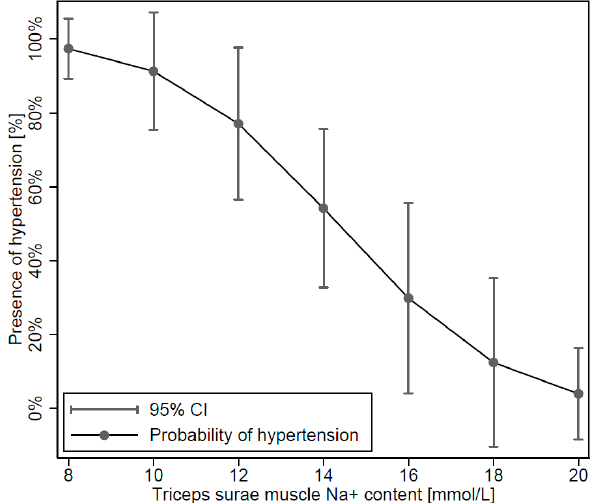
Figure 3: Logistic model showing the probability of hypertension according to muscle Na + content with 95% confidence intervals (CI). ( p = 0.038; N =